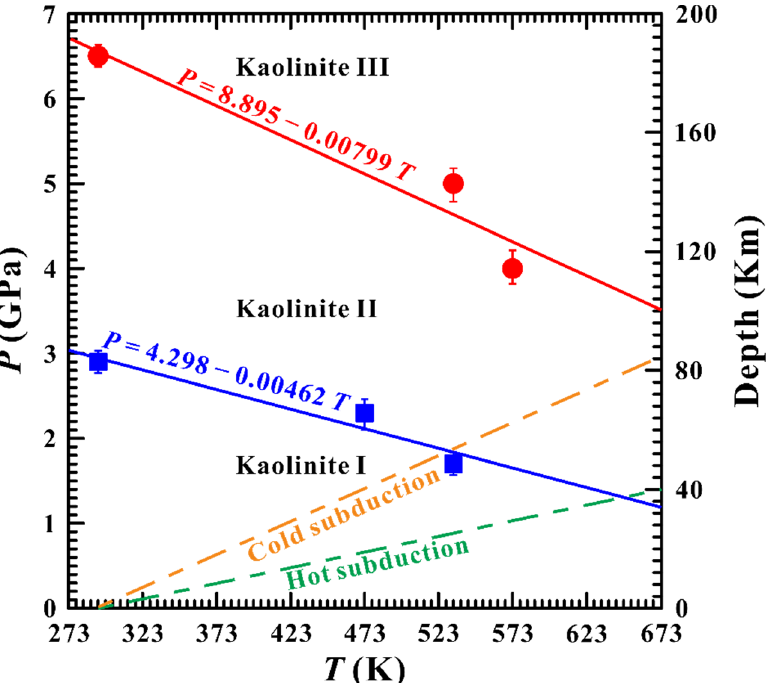
Figure 10. The temperature–pressure phase boundary based on the acquired high-pressure electrical conductivity and Raman scattering results on natural hydrous kaolinite at conditions of pressure ranges of 2.3–6.5 GPa, temperature ranges of 293–673 K, and depth ranges of 38–200 km. In here, two representative geothermal gradients of 5 and 10 K/km are selected to model the cold and hot subduction, respectively (reproduced with permission from the reference of Hong et al. [73]; published by Geoscience World, 2022).